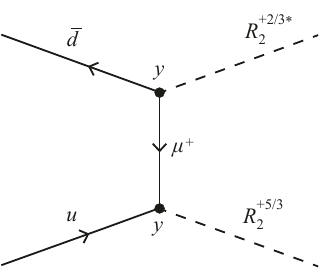
Figure 4 . A self-induced t -channel contribution towards a pair production of the R 2 leptoquark multiplet components at LHC within our flavor